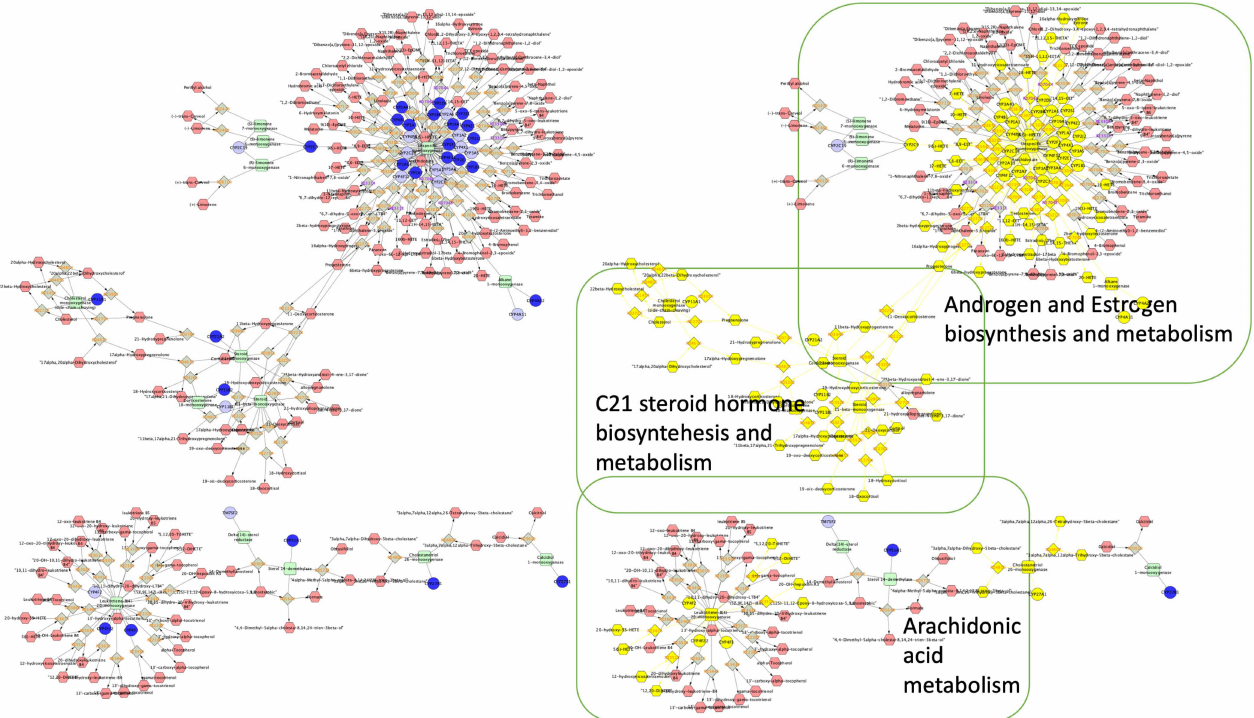
Figure 2. Gene–enzyme–metabolite network involving significant CpG methylations ( p < 0.05). Blue nodes indicate the genes that were found to be significant in patients with Alzheimer’s disease. Yellow nodes indicate the genes, compounds, and enzymes involved in a particular